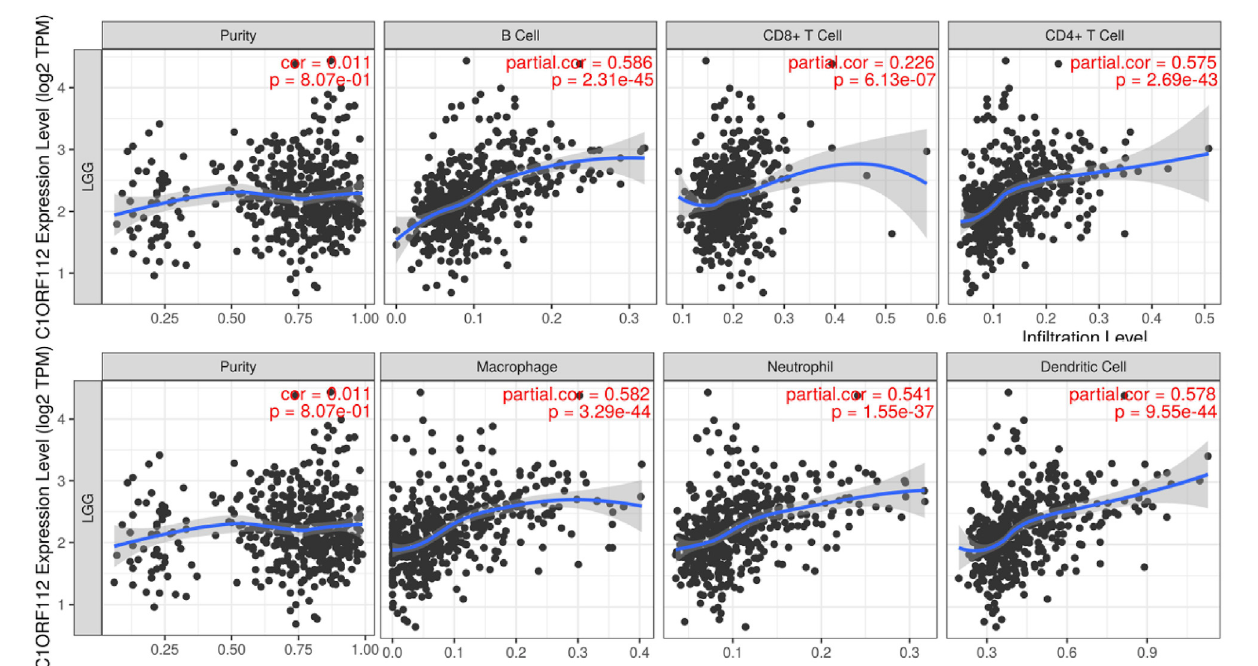
FIGURE 4 | The relationship between C1ORF112 and the level of immune in fi